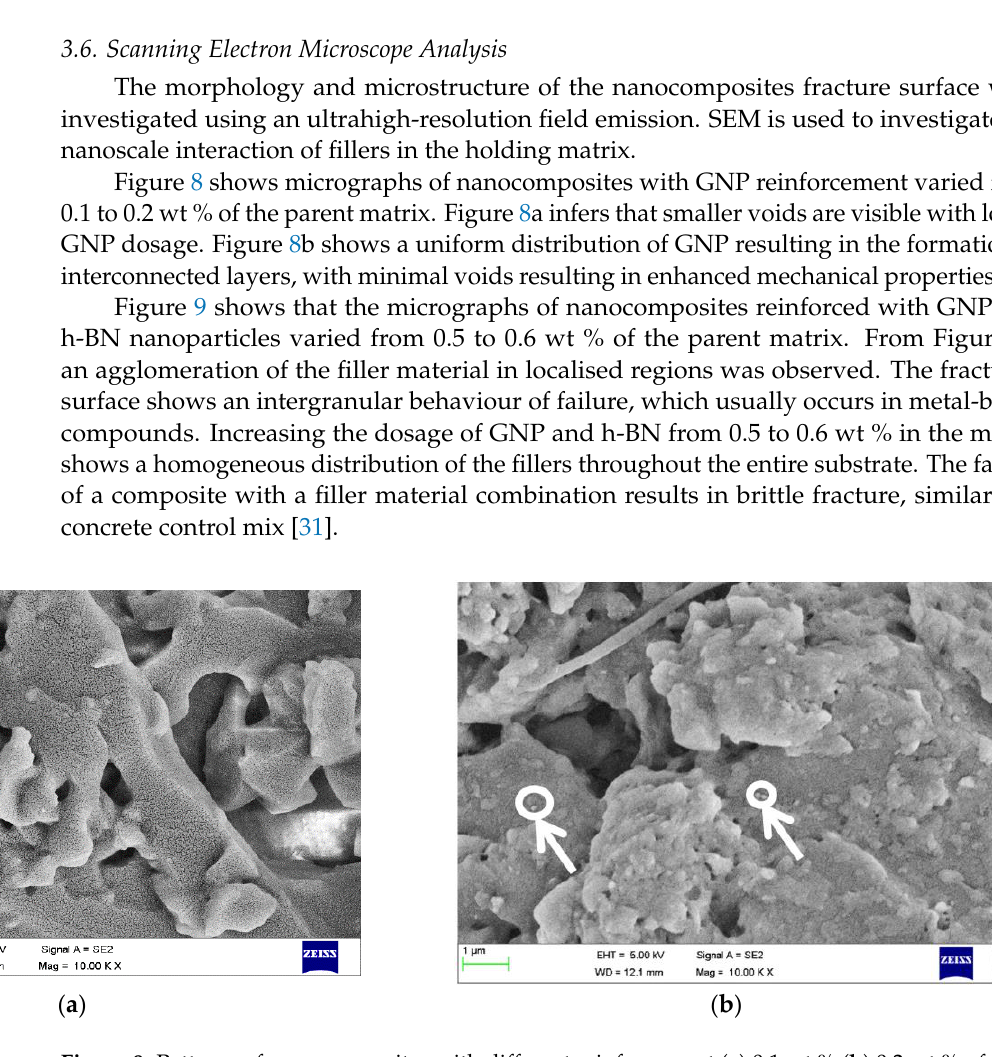
Figure 7. ( a ) FTIR result of the nanocomposite reinforced with GNP (0.2 wt %). ( b ) FTIR result of the composite reinforced with GNP and h-BN (0.6 wt %).